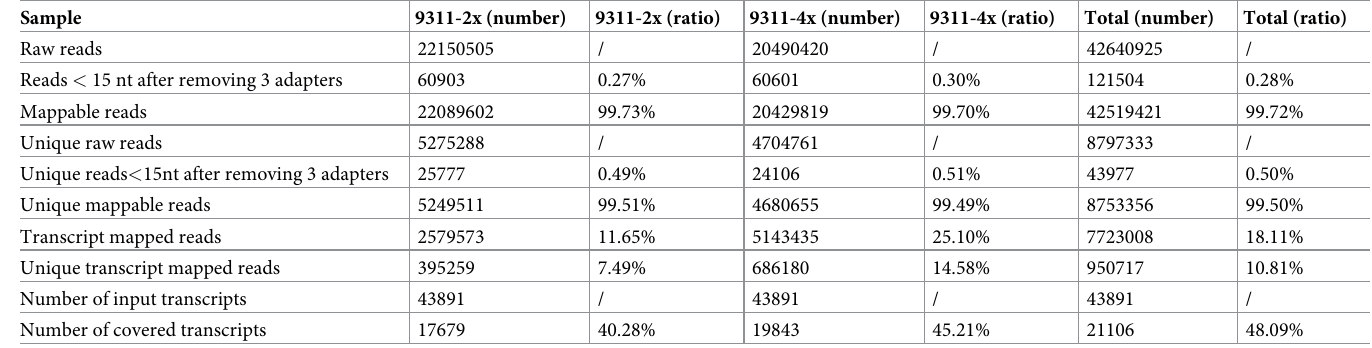
Table 2. Quality evaluation for degradome sequencing